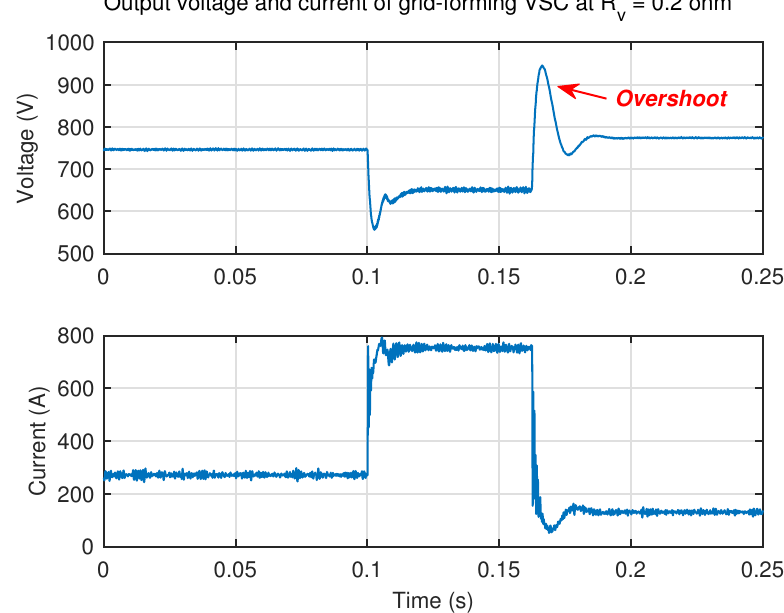
Figure 13. Output voltage and output current of grid-forming VSC when R v is 0.2 Ω